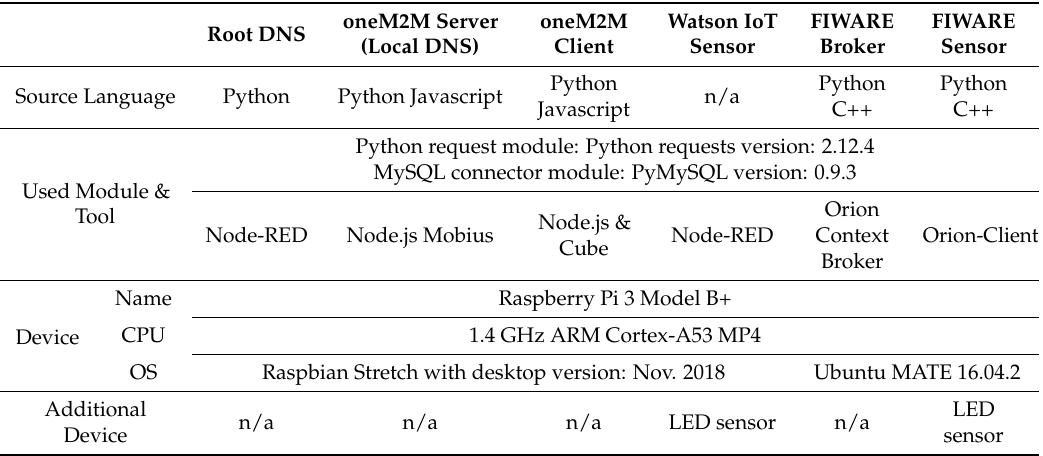
Table 7. Specifications of the implementation environment.